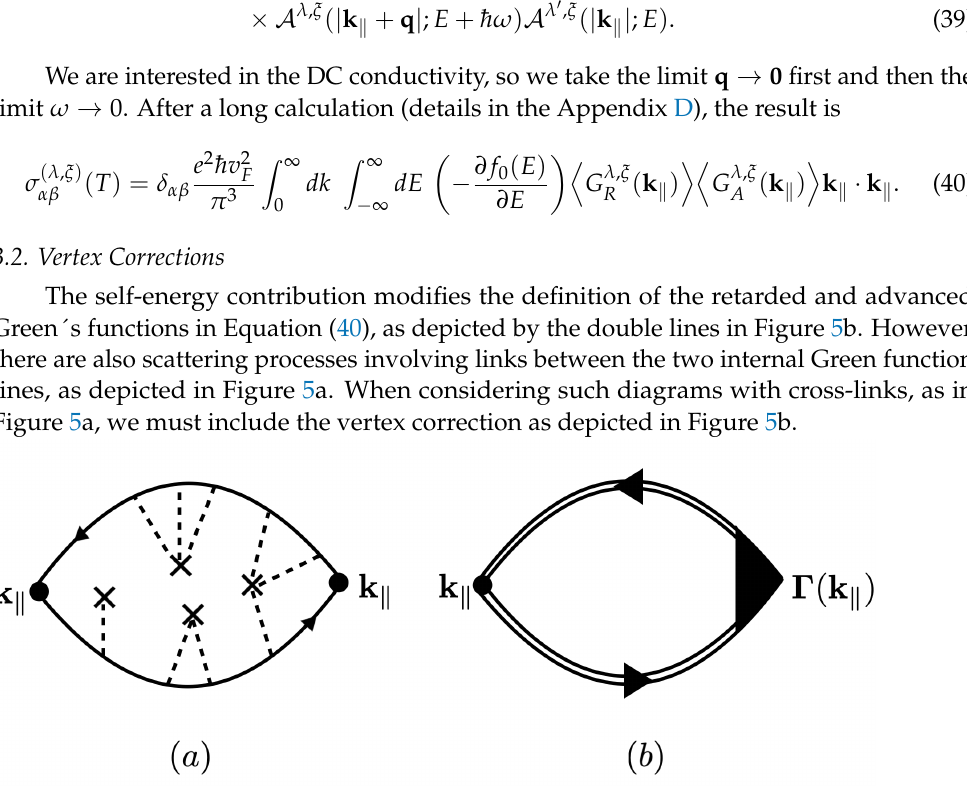
Figure 5. ( a ) A typical diagram contributing to the conductivity in Equation (40), involving the configurational average of the two internal GF with cross-links between them. The upper line corresponds to the retarded GF and the lower to the advanced GF; ( b ) diagrammatic representation of the two complete averaged GF (double lines) corresponding to the sum of all diagrams of the kind in ( a ) with the vertex correction Γ ( k (cid:107) )